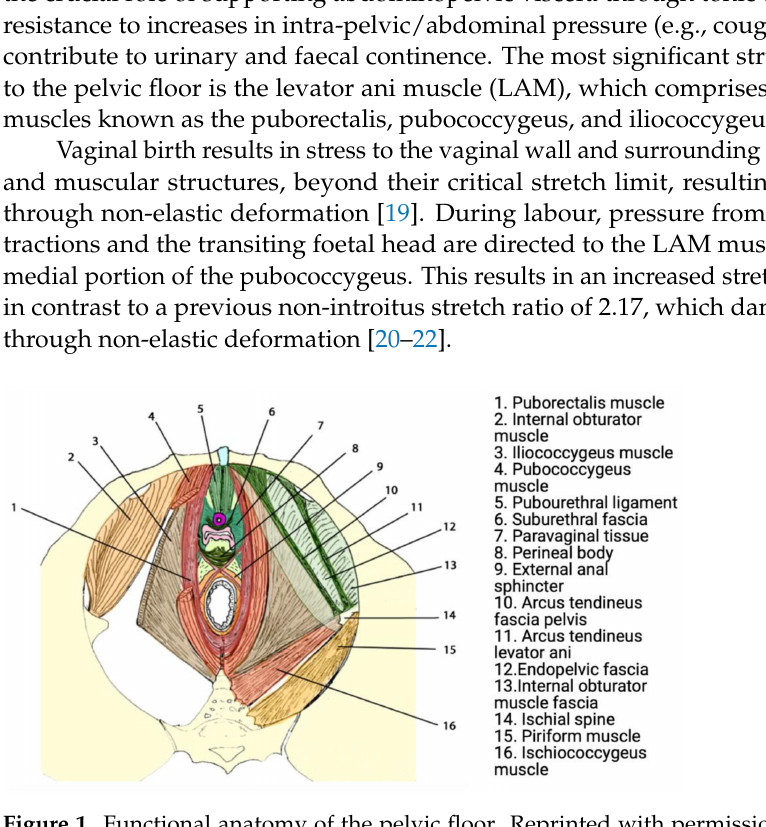
Figure 1. Functional anatomy of the pelvic floor. Reprinted with permission from Lamblin et al. (2016) [23]. Copyright Springer Nature,